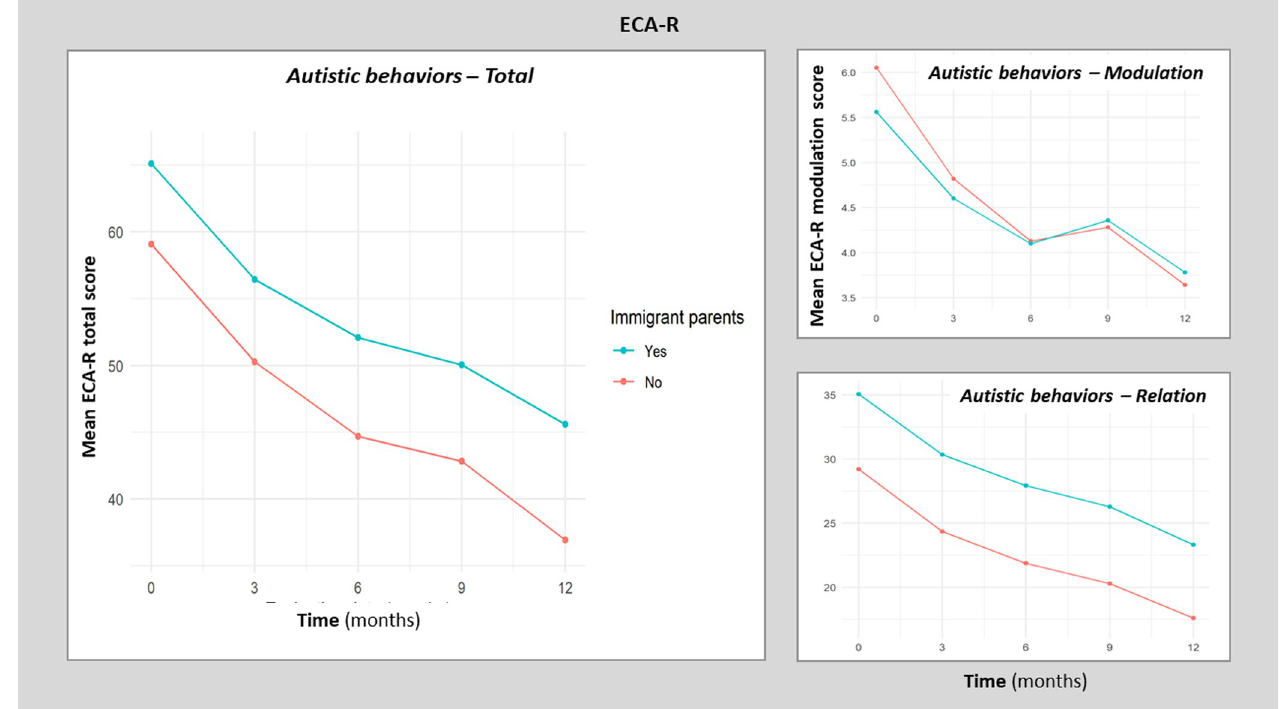
Fig 2. Evolution of ECA-R scores during the 12-month